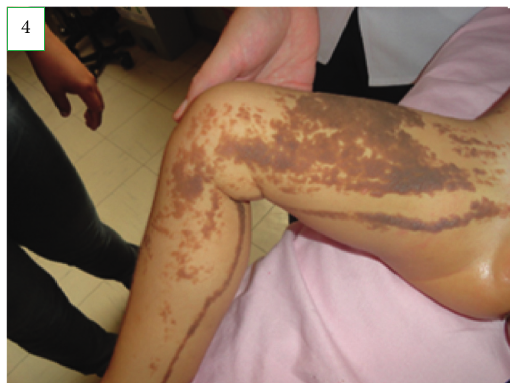
Figure 4: Skin patterns of the verrucous nevi on the right lower extremity